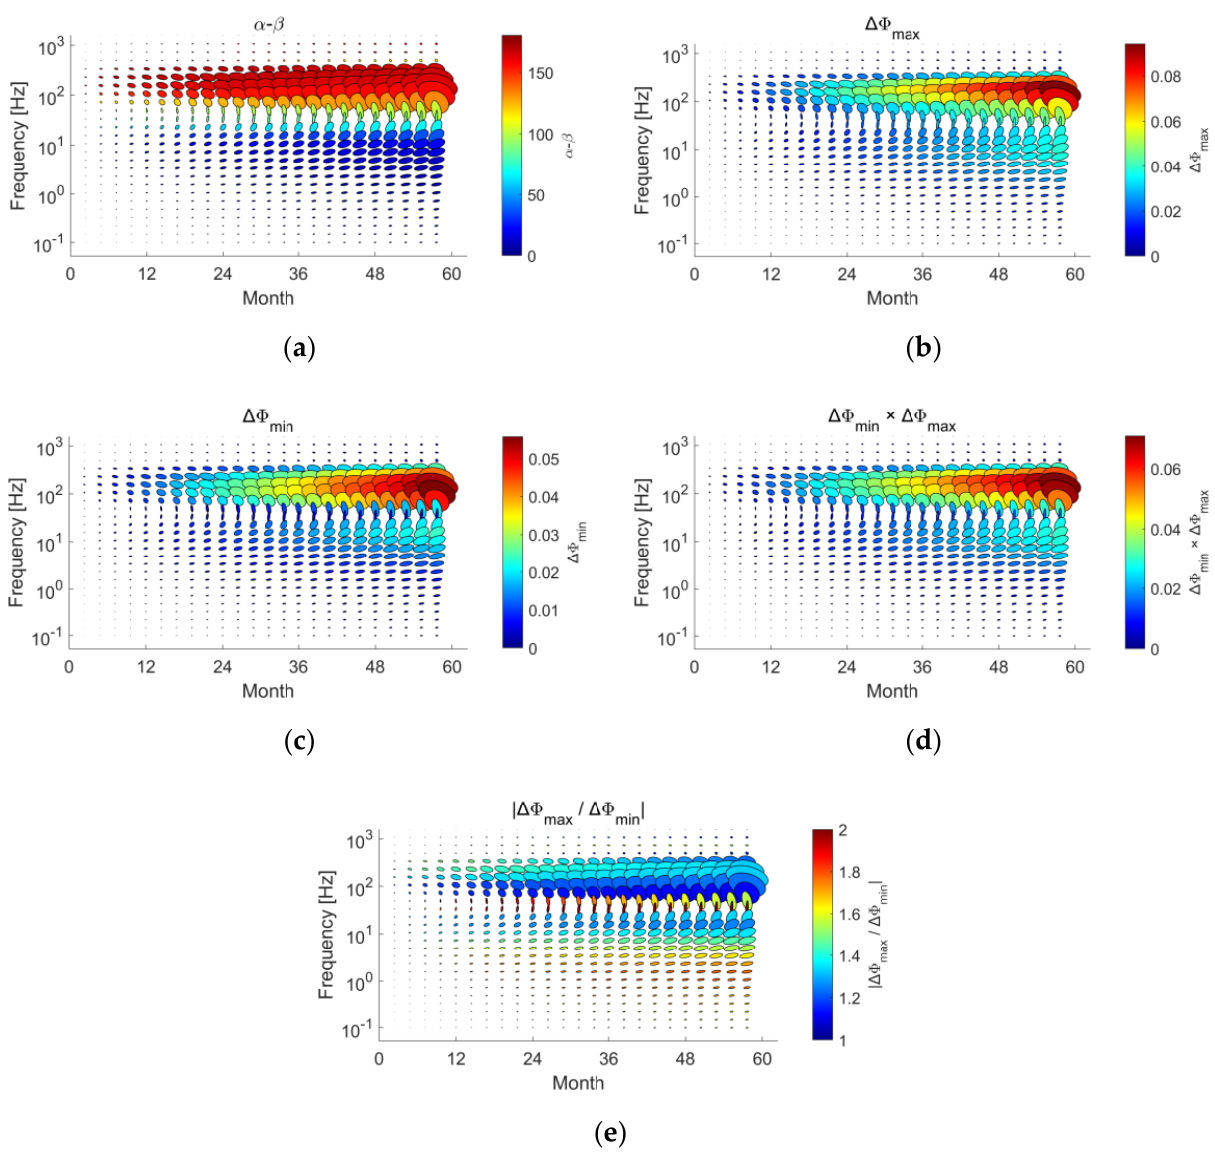
Figure 15. The time-lapse residual phase tensor, where the colors indicate the combined invariants; ( a ) 𝛼 − 𝛽 ; ( b ) Δ𝛷 𝑚𝑎𝑥 ; ( c ) Δ𝛷 𝑚𝑖𝑛 ; ( d ) Δ𝛷 𝑚𝑎𝑥 × Δ𝛷 𝑚𝑖𝑛 and ( e ) Δ𝛷 𝑚𝑎𝑥 /Δ𝛷 𝑚𝑖𝑛 .